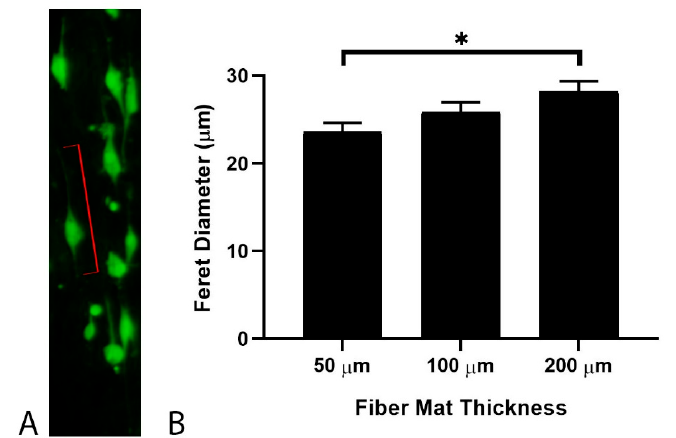
Figure 3. Glioblastoma cell Feret diameter ( A ) as a function of polystyrene (PS)-supported EFM thickness ( B ). Feret diameter is indicated for a representative cell (red lines). A total of 979 cells were analyzed across at least two independent experiments. Levels connected by a star (*) are statistically significant from each other ( p < 0.05).